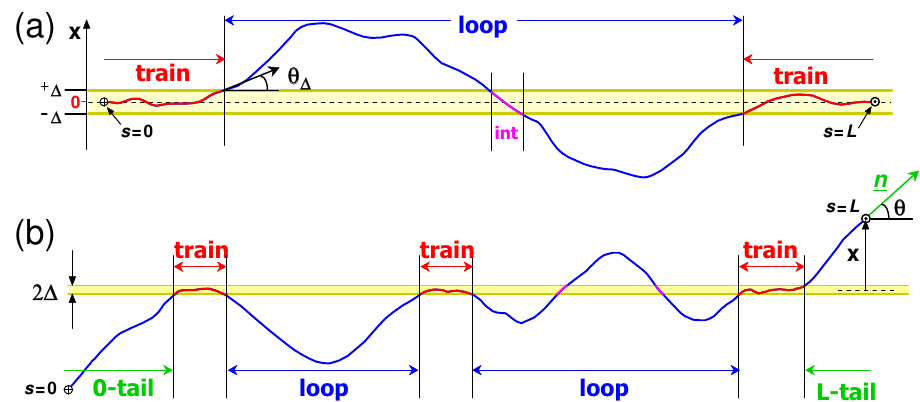
Figure 1. ( a ) A wormlike chain with two ends located in the membrane (at − ∆ < x < ∆ ). The chain segments are oriented at small angles θ to the membrane plane ( x = 0). Typically, | θ | (cid:46) θ ∆ in the ‘train’ sections, and | θ | (cid:29) θ ∆ in the ‘loops’ (see Equation (10)). ( b ) A wormlike chain of contour length L with free ends; the chain is aligned by attraction to a penetrable membrane. The right-hand end is located at distance x from the membrane mid-plane; its orientation is defined by the unit vector n . The chain involves ‘train’ sections trapped in the short-range attraction layer representing the membrane, ‘loops’ of different sizes away from it, and two